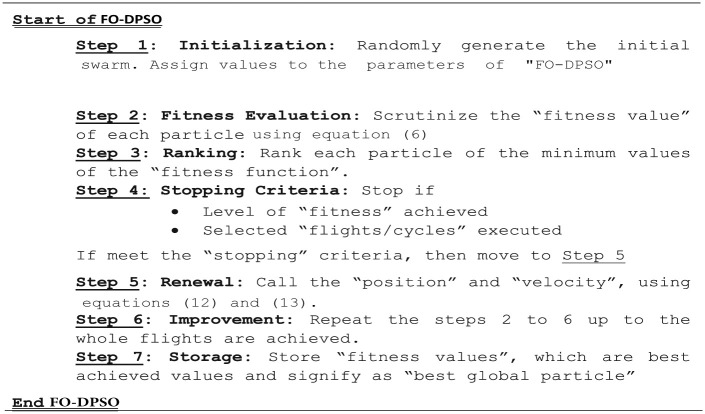
Pseudo-code of our soft computing technique.